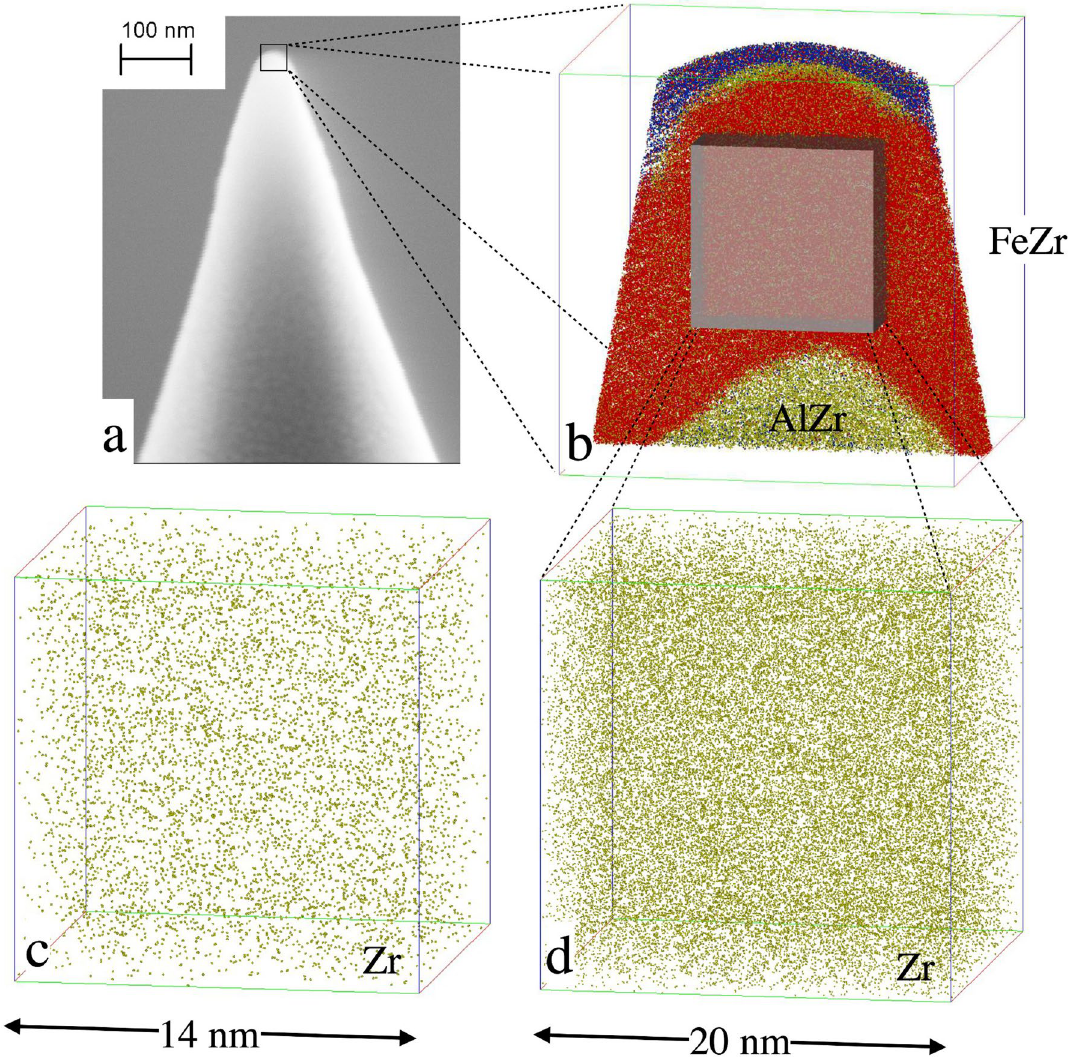
Fig. 1. ( a ) Illustration of a Si tip covered by an amorphous structure, consisting of three layers. The atomic distribution is illustrated in ( b ). At the bottom, the Al 75 Zr 25 seeding layer (green) is seen, covered by a Fe 81 Zr 19 (red and green) layer. Topmost the presence of oxygen (blue) demonstrates the almost complete oxidation of the capping layer ( Al 75 Zr 25 ). In ( d ) the distribution of Zr in Fe 81 Zr 19 is illustrated and in ( c ) corresponding distribution of Zr is shown for the Fe 91 Zr 9 alloy is